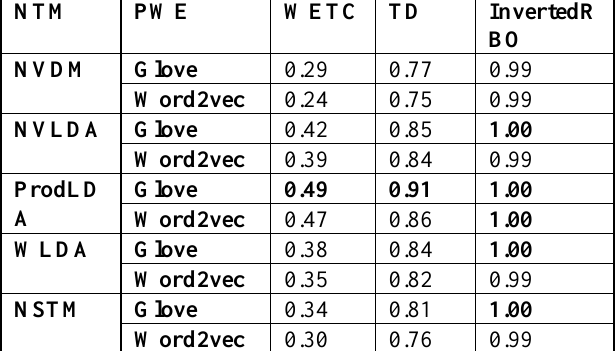
Table 3. The WETC and TD for different models on the Arabic dataset.